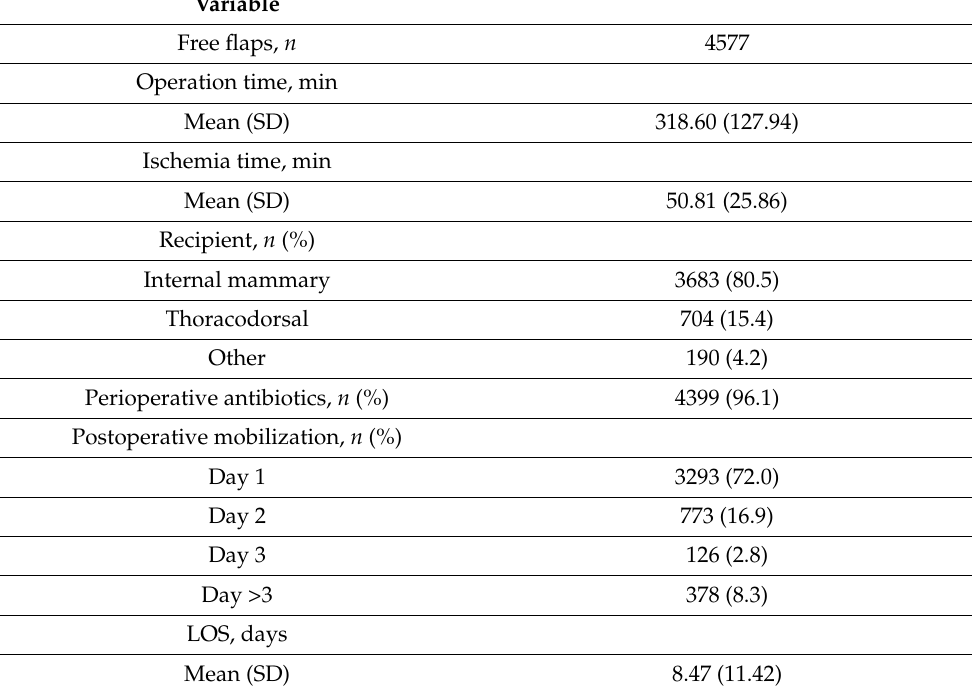
Table 3. Perioperative